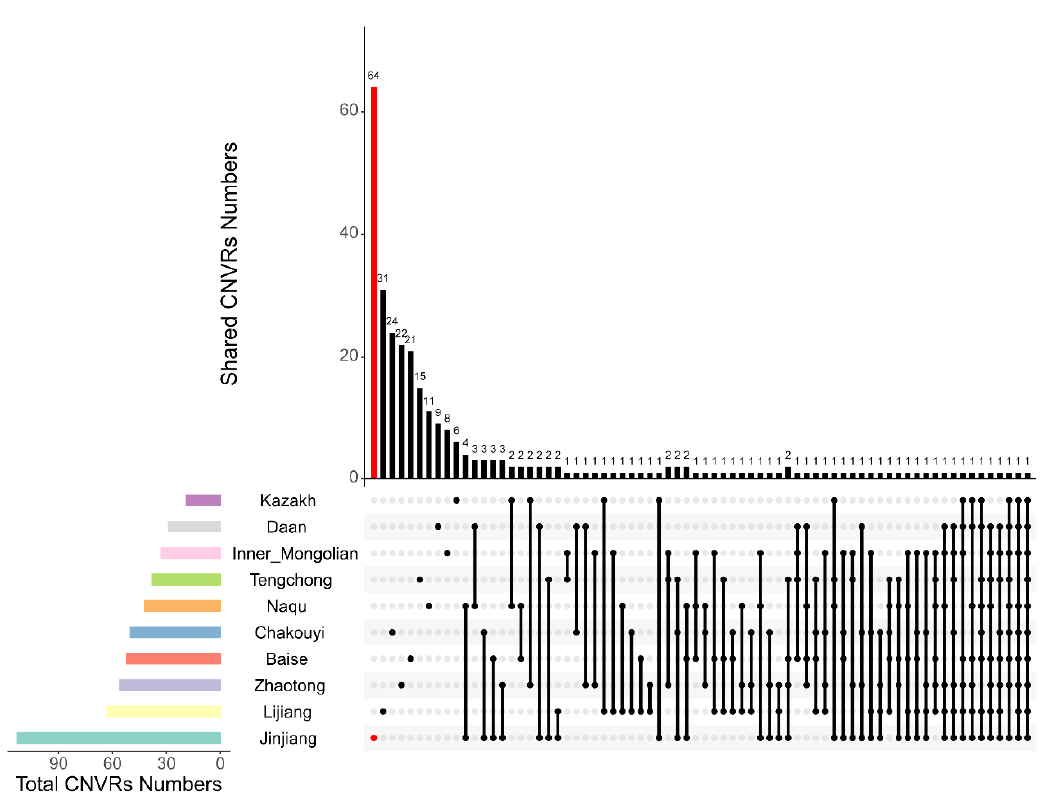
Figure 1. Breed-specific CNVR analysis across the ten horse breeds. The lower left bar chart shows the total amount of CNVRs contained in each original CNVR dataset (classified by horse breeds). In the lower right chart, the first 10 dots indicate the corresponding horse breeds on the left, and their breed-specific CNVR numbers are shown in the upper bar chart. The shared CNVRs between or among breeds are indicated with the vertical lines connecting the dots which represent the breeds on the left, and the numbers of CNVRs shared by the connected breeds are shown in the upper bar chart.